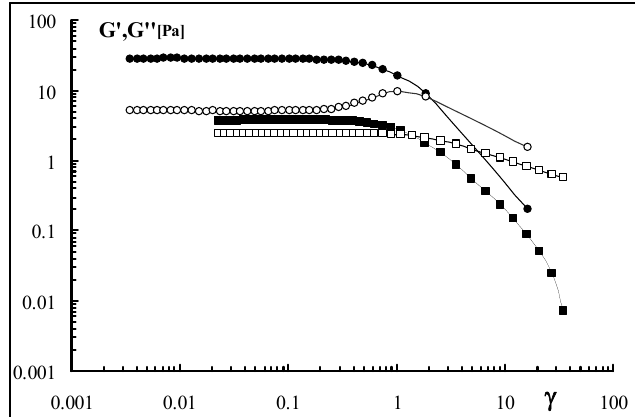
Figure 4. Viscoelasticity plot for dialysed Sclg ( ● , ○ ) and for Sclg sonicated for 5 min ( ■ , □ ); cp = 0.7%, T = 25 °C (G’ = full symbols; G” = empty symbols).